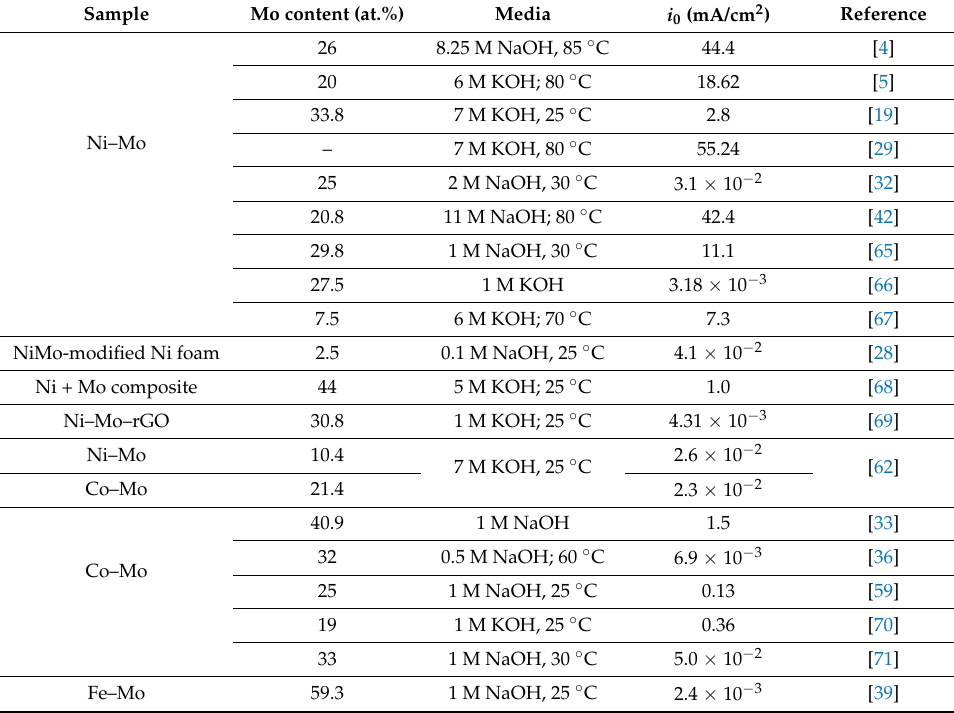
Table 5. Comparison of the HER apparent exchange current density values, i 0 , extracted from the published data for electrodeposited Ni–Mo, Co–Mo and Fe–Mo alloy electrodes.